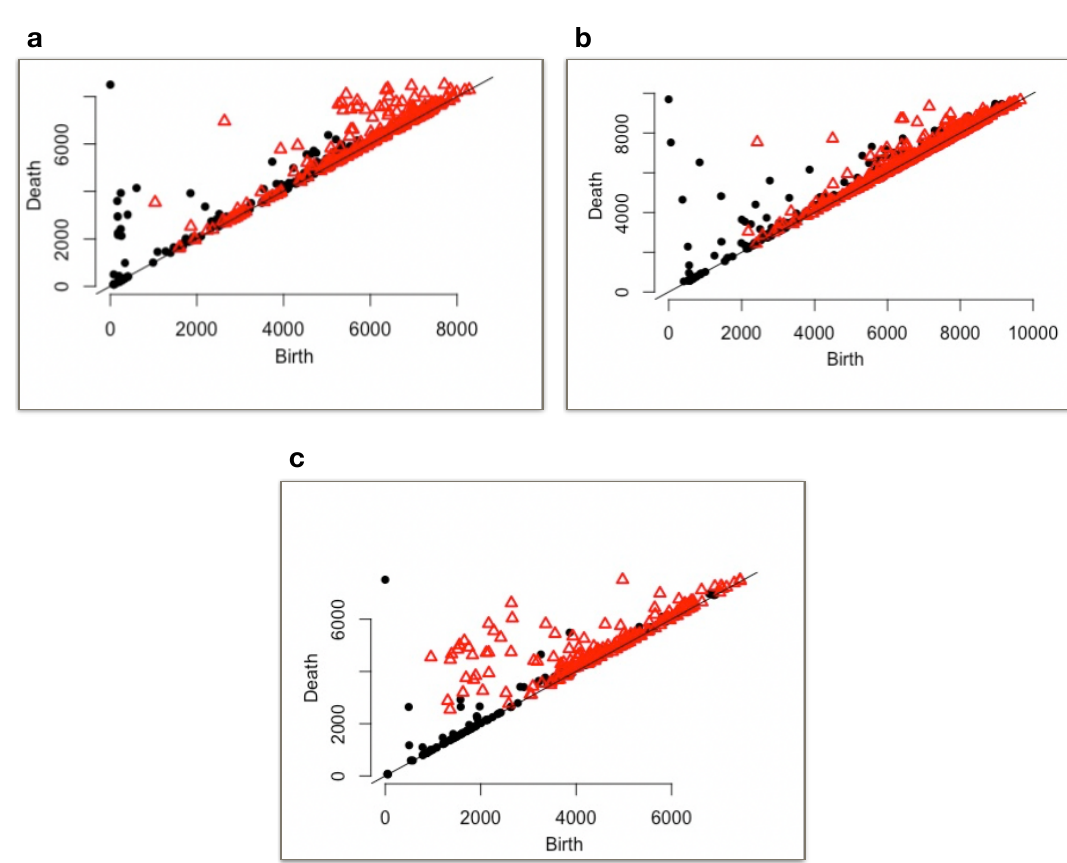
Figure 5. Persistence diagrams of surface textures of ( a ) 4 min , ( b ) 8 min and ( c ) 10 min of immersion time of PC.